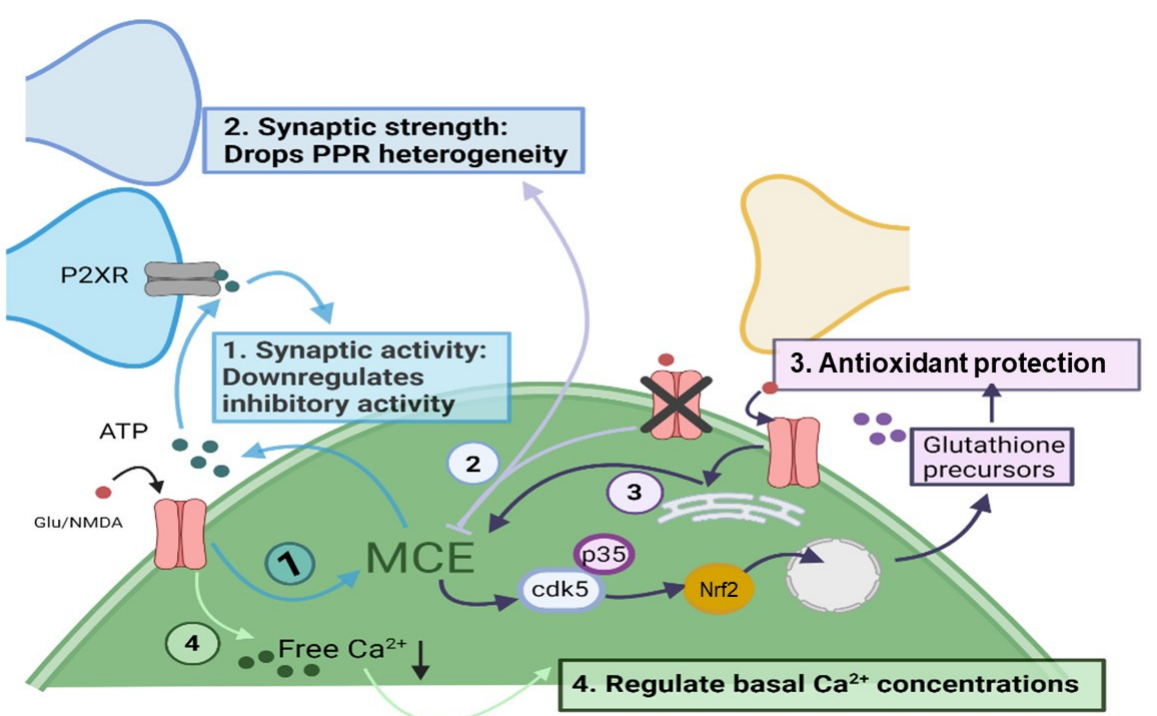
Figure 3. Functional implications of astrocyte NMDA receptors. The following may occur as a result of Antioxidant protection NMDAR activity, possibly via astrocyte calcium events: (1) Modulation of synaptic activity; ATP gliotransmission is evoked that acts on presynaptic P2XRs and thus downregulates inhibitory activity [130]. (2) Regulation of synaptic strength: reduced astrocyte NMDAR expression decreases the paired-pulse ratio variability [49,139] (3) Protection of neurons against antioxidant stress; NMDAR activation upregulates expression of cdk5/p35 that promotes expression of glutathione precursors through Nrf2 [121]. (4) Regulation of basal astrocyte Ca 2+ concentrations, which can define MCEs characteristics such as amplitude and peak frequency [26,27].